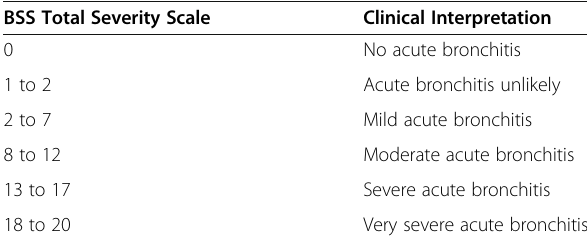
Table 1 Total Bronchitis Severity Scale: Relationship to severity of acute bronchitis [24] (score in this study not >